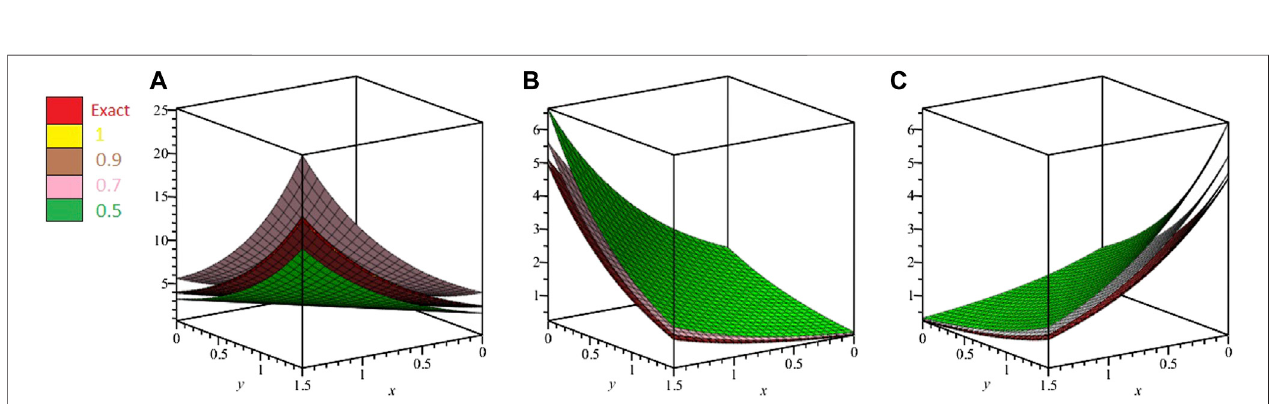
FIGURE 3 | ETDM (A) 3D μ -solution, (B) 3D v-solution, and (C) 3D ω -solution graph, respectively, at various values of α , β and γ of Problem 2.